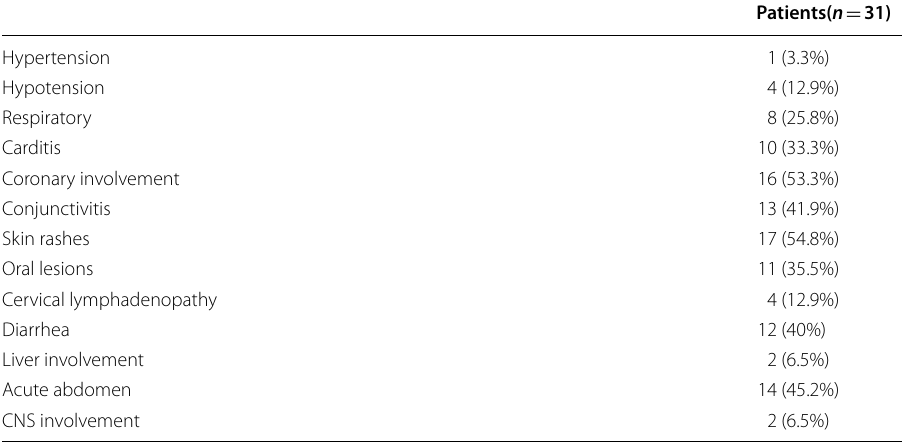
Table 3 The percentage of clinical manifestations in hyper-inflammatory features of pediatric patients after